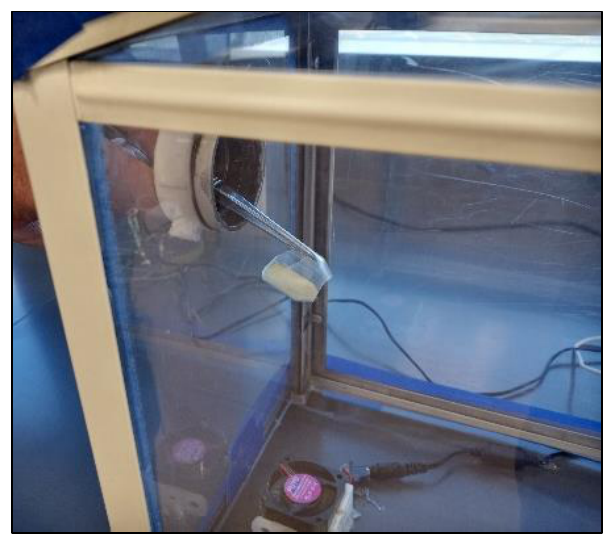
Figure 2. Experimental setup with terrarium opening and pollen cup over the fan.